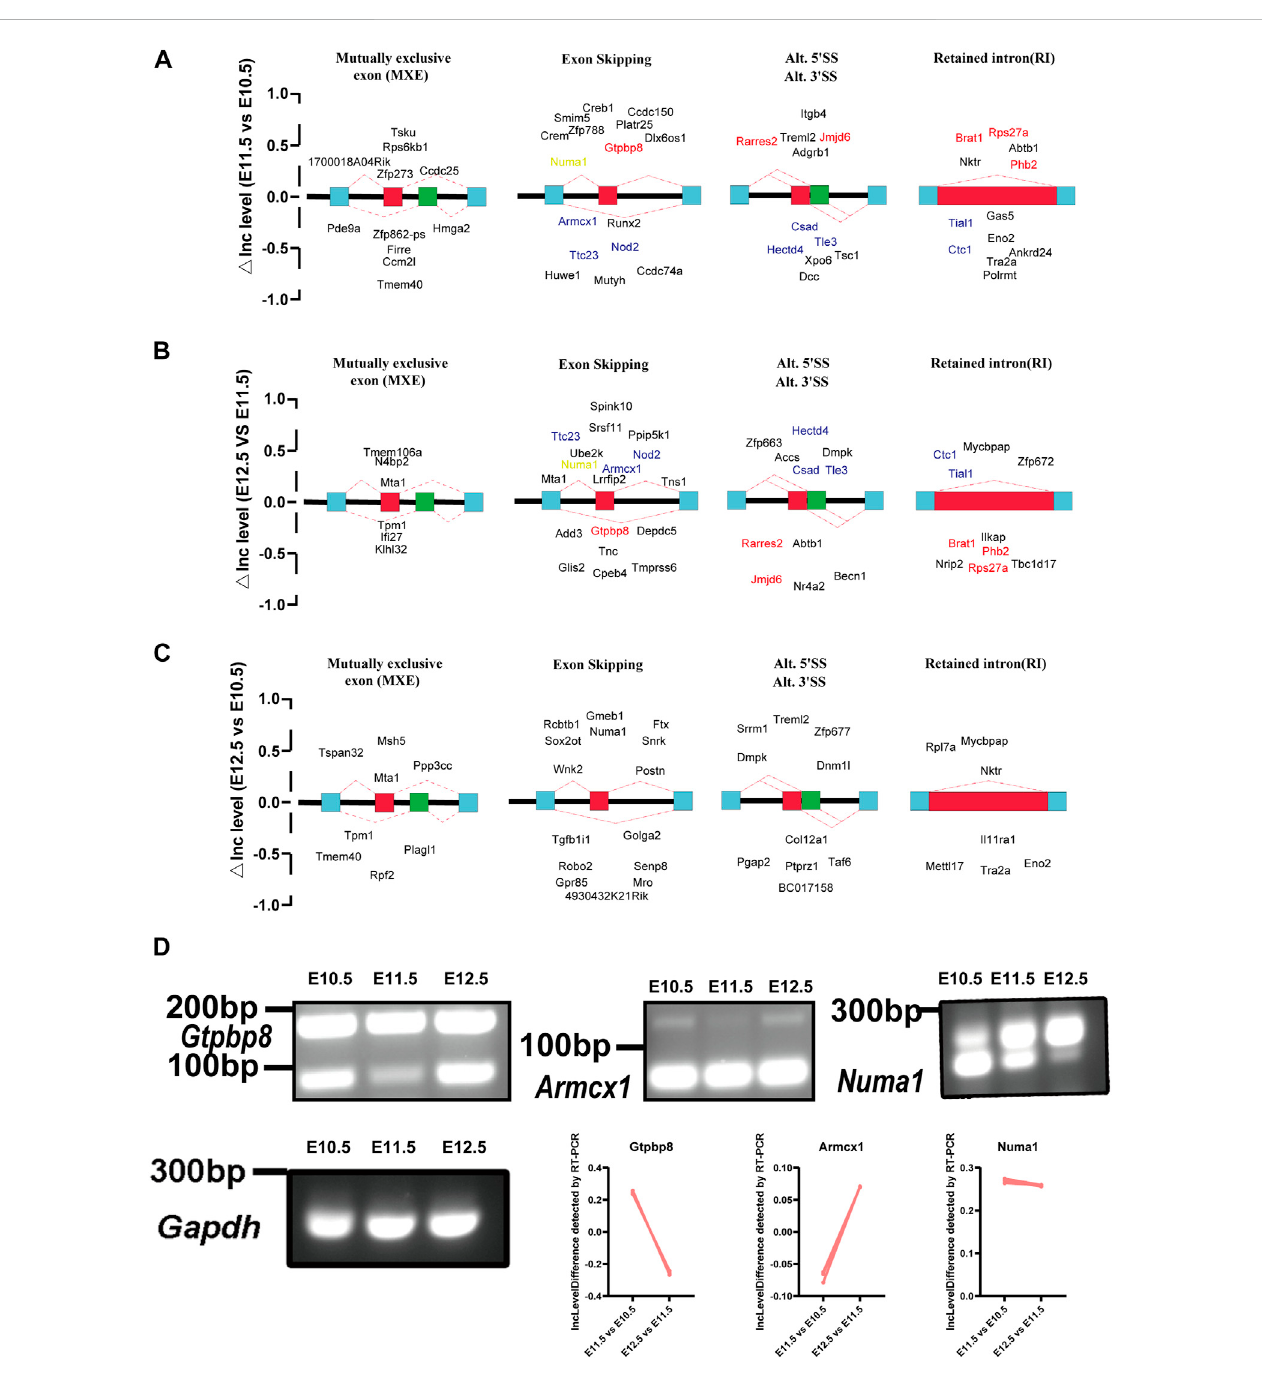
FIGURE 6 Changes in alternative splicing events in lambdoidal junction tissues of mice at embryonic days 10.5, 11.5, and 12.5. Development-associated changes in alternative splicing events among comparison groups (A) E11.5 vs. E10.5, (B) E12.5 vs. E11.5, and (C) E12.5 vs. E10.5. Red: changes of △ Inc level that fi rst increased and then decreased; blue: △ Inc level fi rst decreased and then increased; orange: △ Inc level ofNuma1 persistently upregulated from E10.5to E12.5. (D) RT-PCR validation to demonstrate the expression levels of Numa1 from E10.5 to E12.5. IncLevel Difference ( △ IncLevel) = IncLevel1 − IncLevel2; IncLevel1 = the expression of exon inclusion isoform/the expression of two isoforms (in experimental group 1), IncLevel2 = expression of exon inclusion isoform/expression of two isoforms (in experimental group